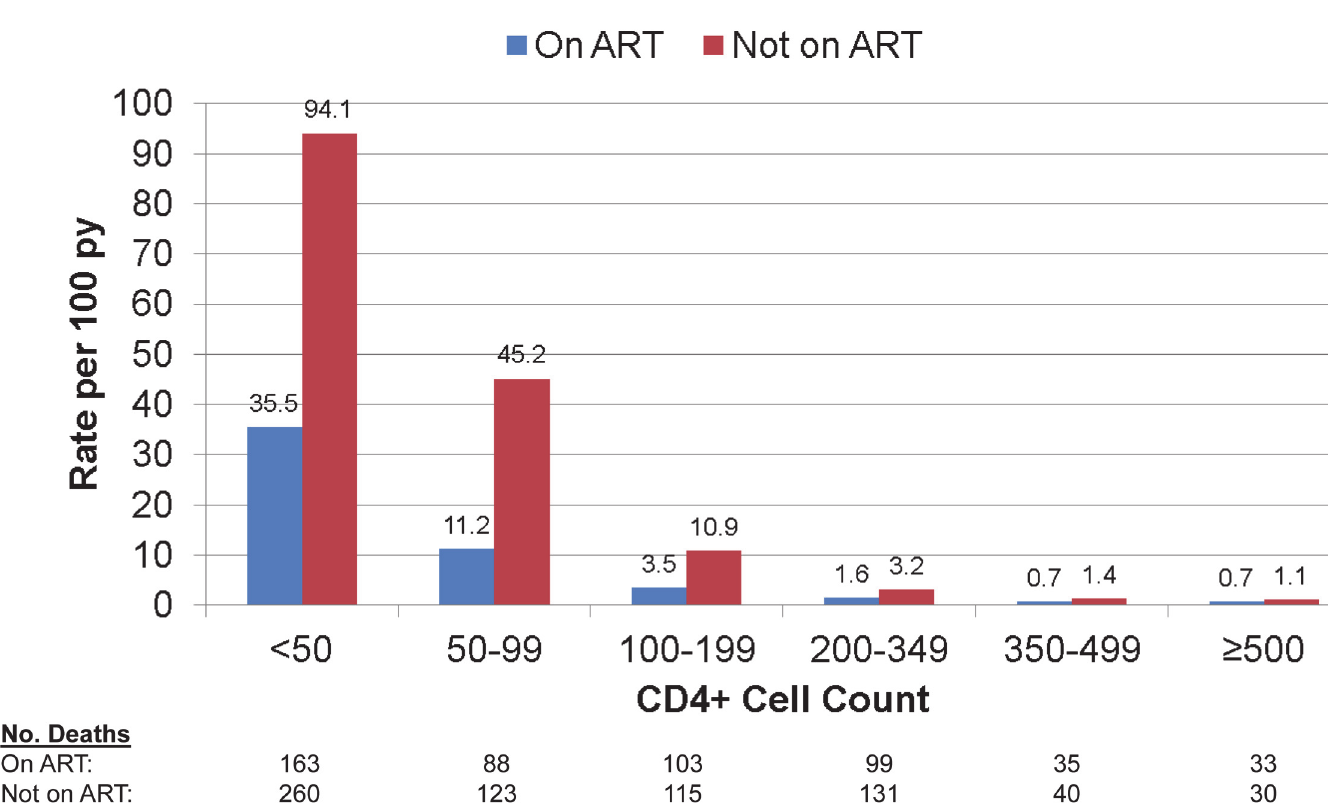
Fig 4. Mortality by Latest CD4+ Cell Count and ART status for Phidisa